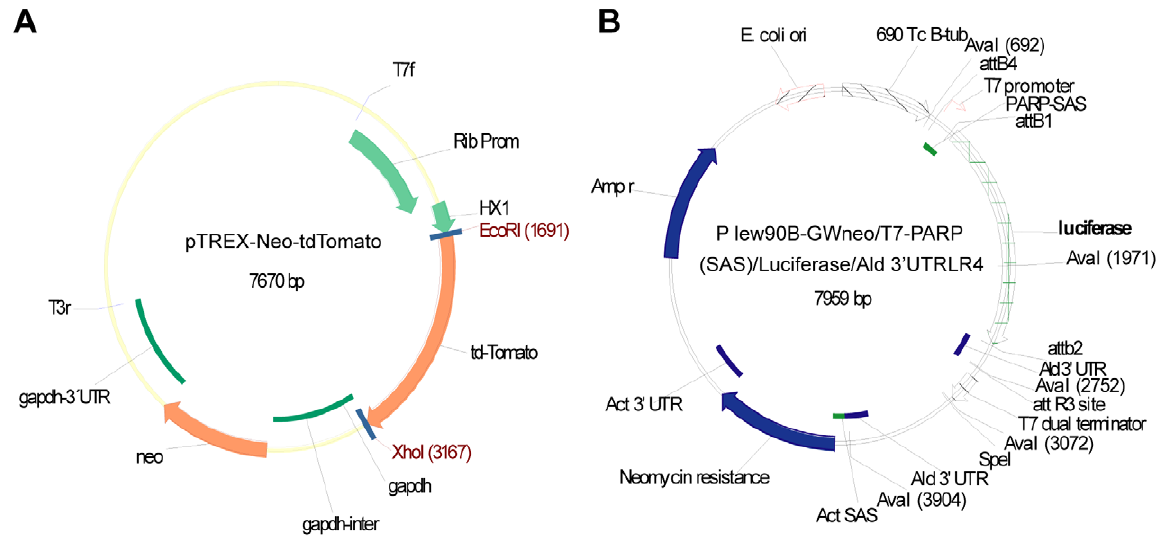
Figure 1. Plasmids used in the generation of fluorescent and bioluminescent T.cruzi . Schematic representation of (A) the pTrex-Neo- tdTomato plasmid, and (B) the pLew90 b -GW/T7/PARP SAS/luciferase/Aldolase 3 9 UTR plasmid used for generation of the T. cruzi reporter lines.